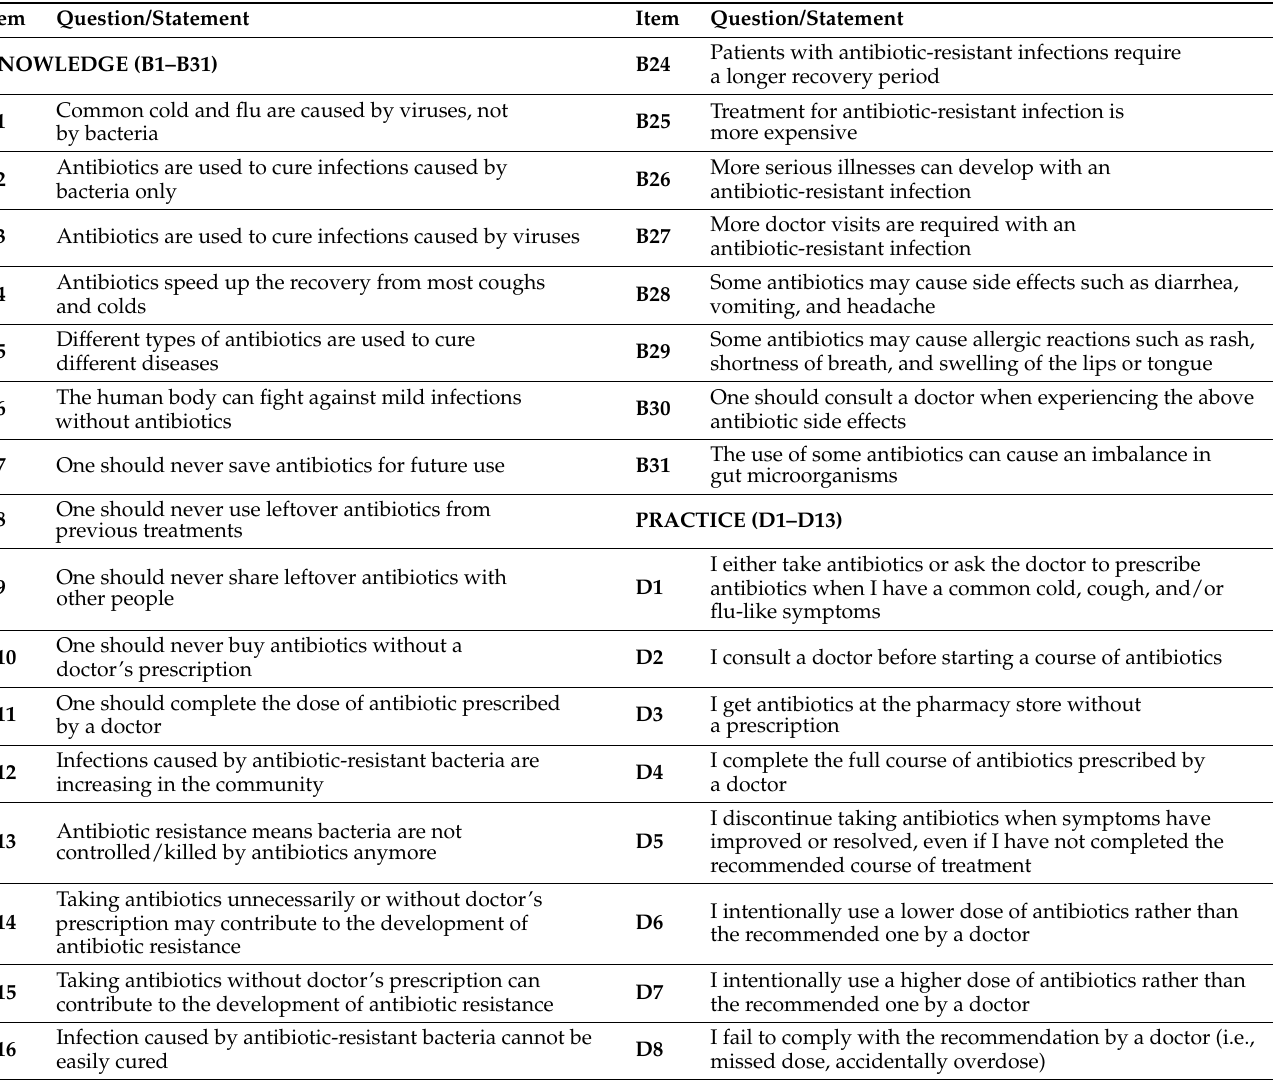
Figure 1. Percentages of correct respondent responses on Vietnamese public knowledge ( A ) and practice ( B ) regarding antibiotic use and resistance ( n = 1306). The full questions/statements (B1–B31 and D1–D13) are shown in Table 3; *, the correct response to these questions is False/Don’t agree. Table 3. List of all knowledge (B1–B31) and practice (D1–D13) questions/statements regarding antibiotic use and ABR among the public in